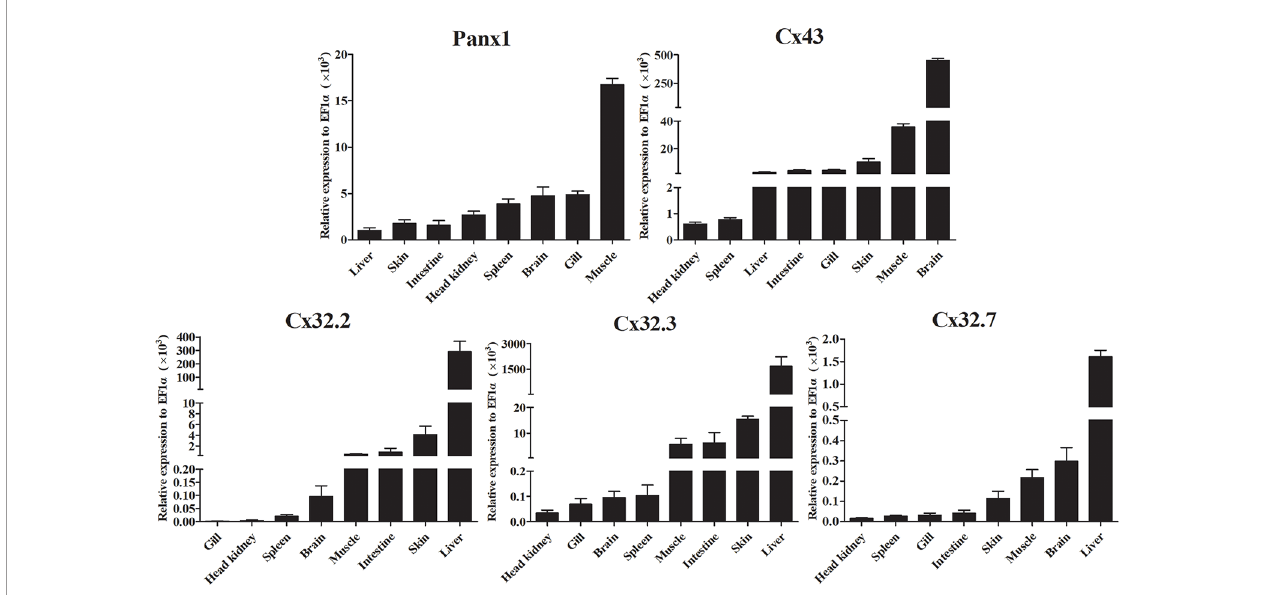
FIGURE 5 | Expression analysis of Lm Panx1, Lm Cx32, and Lm Cx43 in tissues by qPCR. The expression level of each gene was normalized to that of EF1 a . Data are presented as mean ± SEM (N =